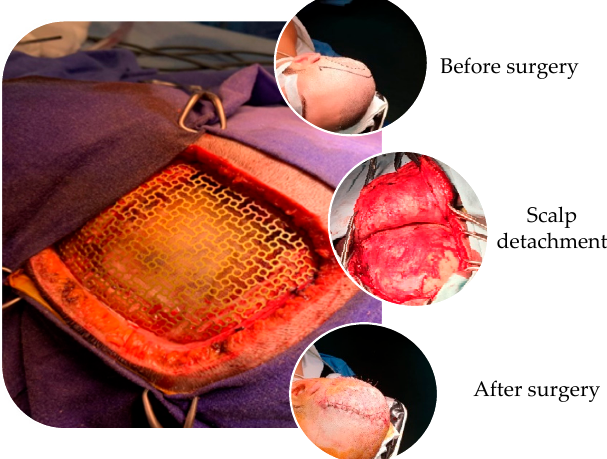
Figure 1. Intraoperatively, surgical details of titanium cranioplasty procedure in the case of a large defect (from private collection of Assoc. Prof. Aurel Mohan).